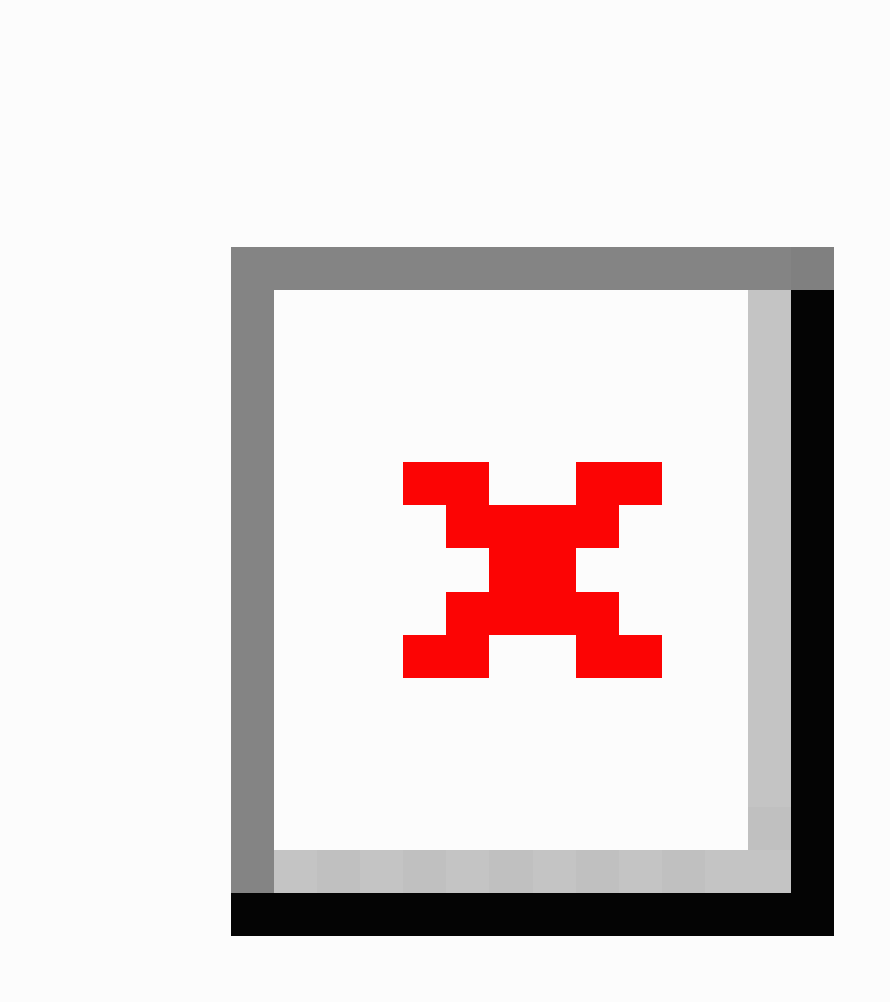
Figure 9. Average daily usage per day per